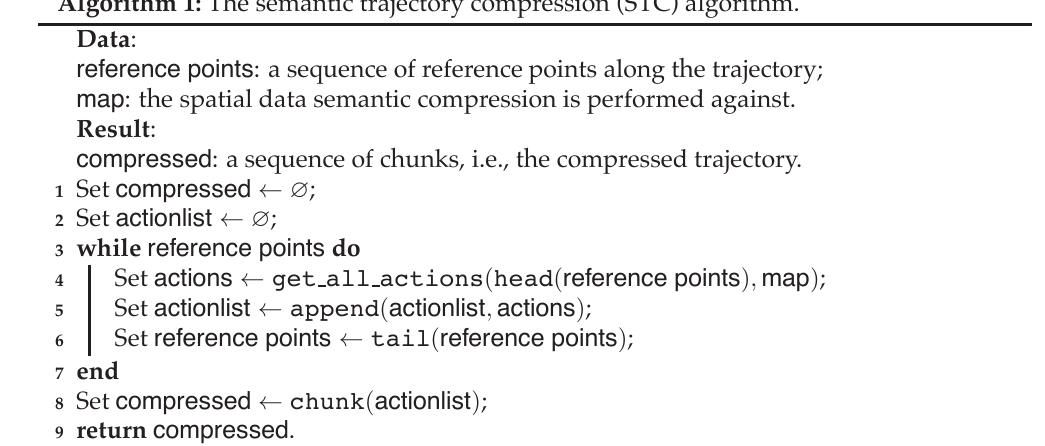
Algorithm 1: The semantic trajectory compression (STC)